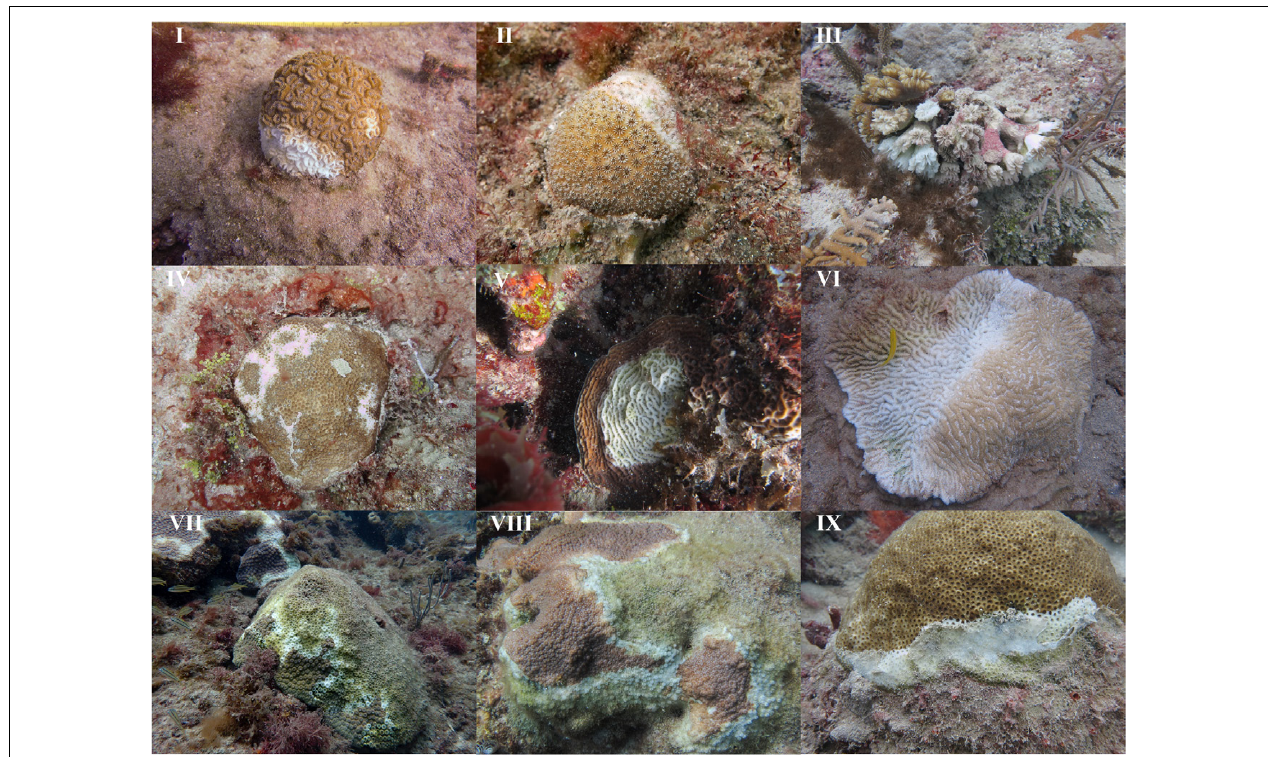
FIGURE 4 | Images of 9 of the 11 species affected by white syndrome during the outbreak. (I) Dichocoenia stokesii , (II) Stephanocoenia intersepta , (III) Eusmilia fastigiata , (IV) Siderastrea siderea , (V) Agaricia sp., (VI) Meandrina meandrites , (VII) Montastraea cavernosa , (VIII) Orbicella sp., (IX) Solenastrea bournoni .